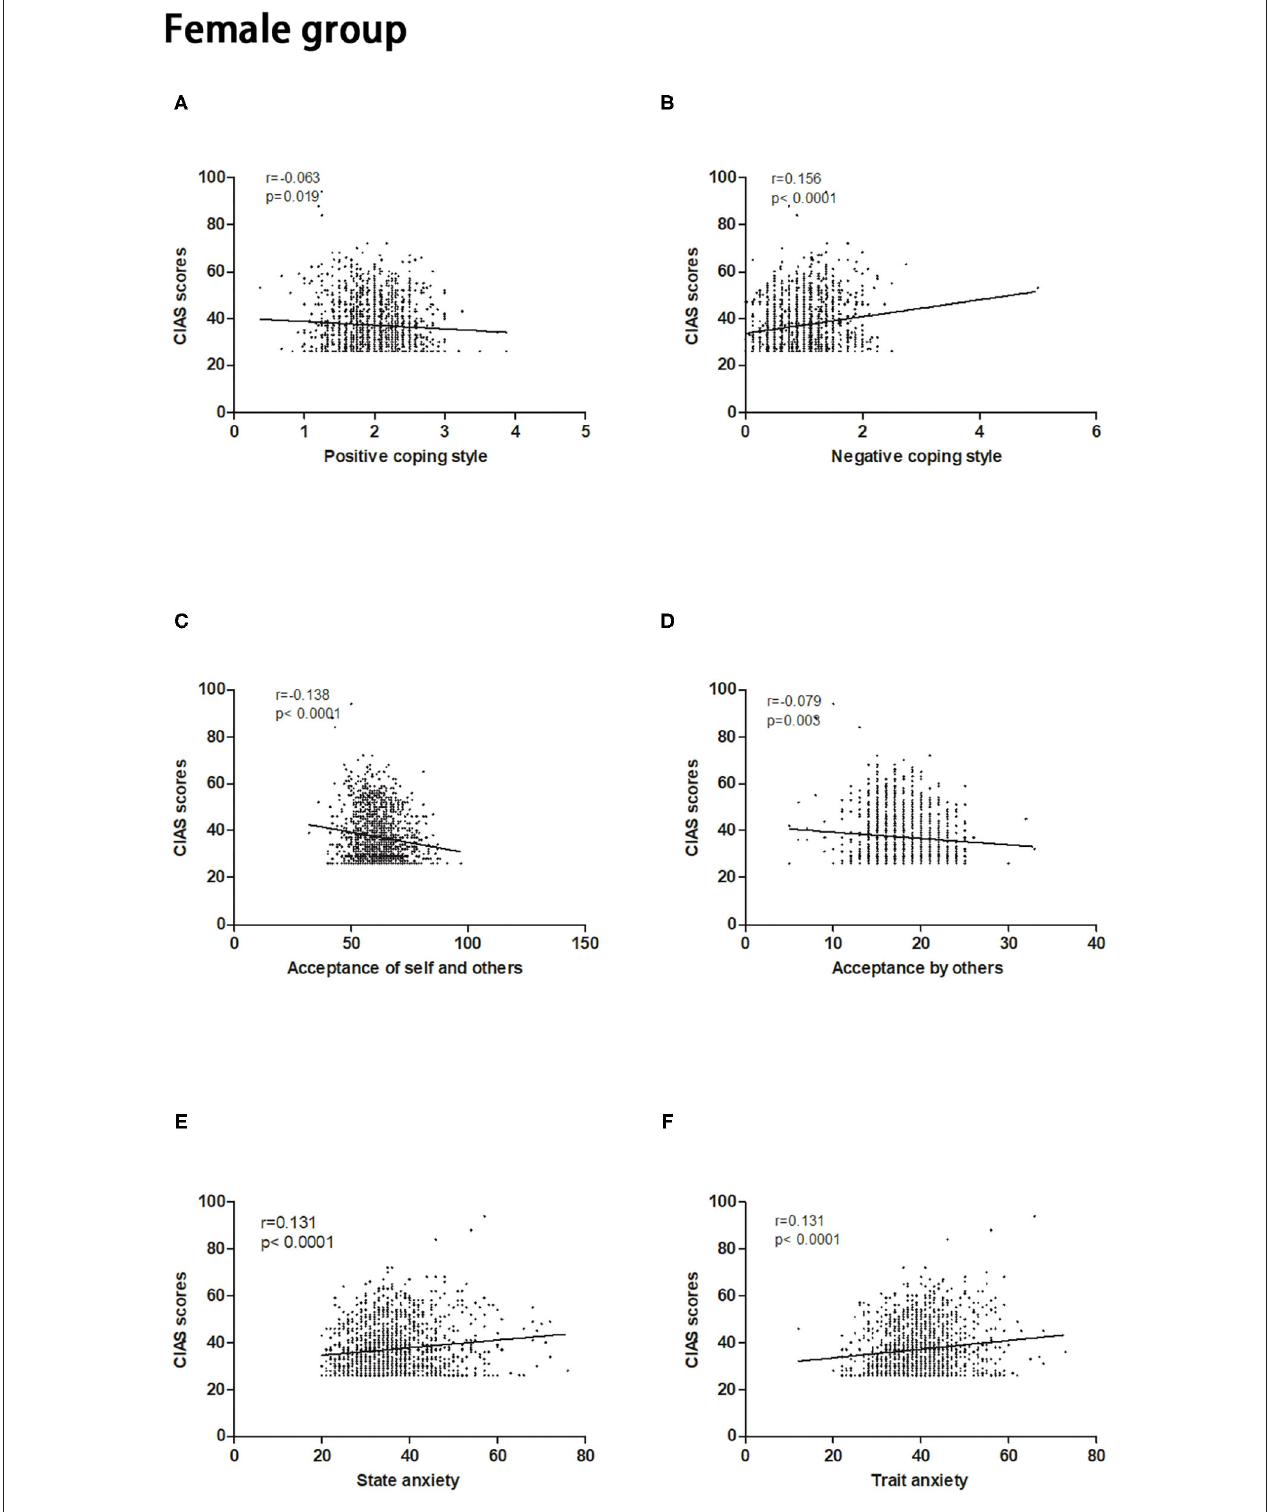
FIGURE 2 | Correlations between the severity of Internet addiction and psychological characteristics in the female group. (A,C,D) Negative correlations were observed between CIAS scores and acceptance of self and others, acceptance by others and positive coping style. (B,E,F) Positive correlations were observed between the CIAS scores and negative coping style, state anxiety and trait anxiety. CIAS, Chinese Internet Addiction Scale.